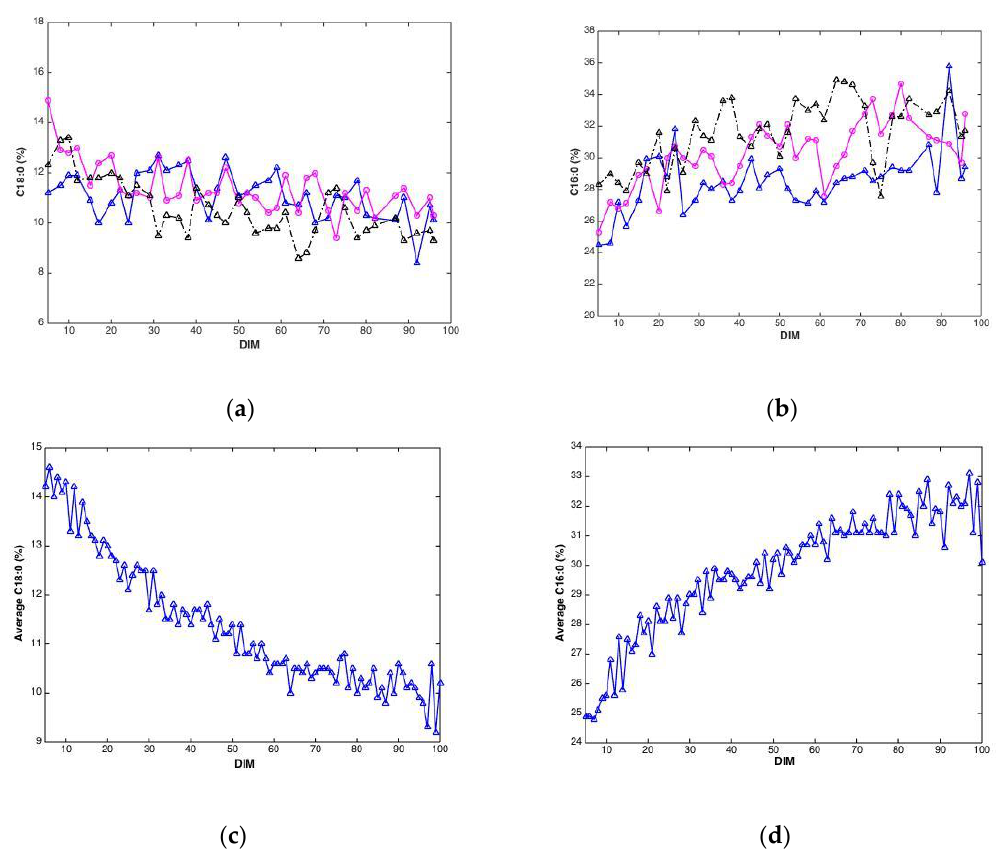
Figure 3. Fatty acid content (percentage of total weight of fatty acids) C18:0 (a) and C16:0 (b) during 5–100 DIM for three individual cows, and calculated as the average C18:0 (c) and C16:0 (d) of all cows at a given DIM.